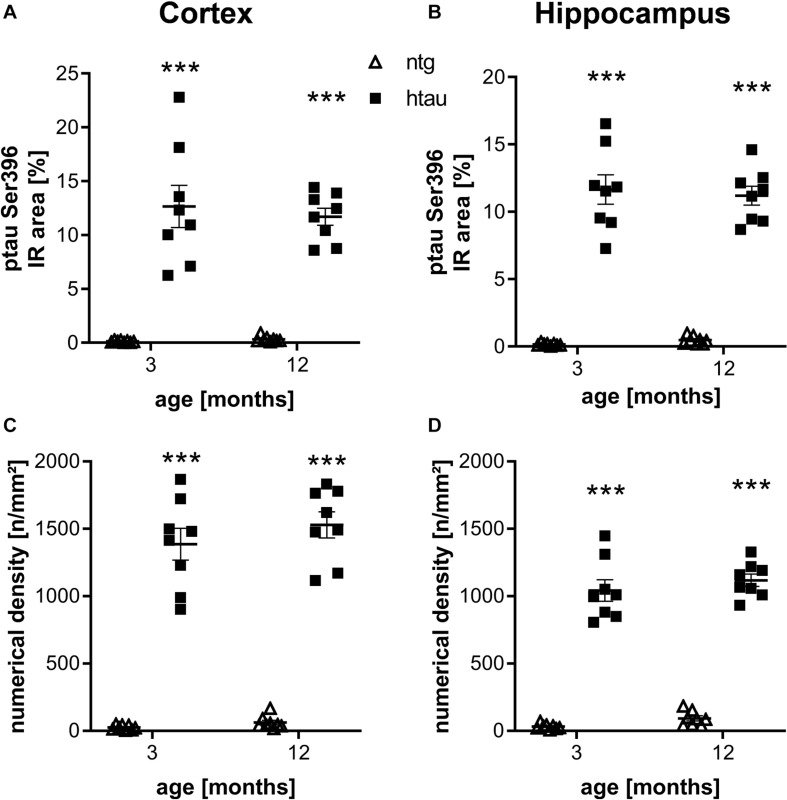
Quantification of ptau Ser396 levels in the cortex and hippocampus of 3 and 12 month old htau mice compared to ntg littermates by PHF13 antibody. (A,B): Immunoreactive area in percent in the cortex (A) and hippocampus (B). (C,D): Object density in n/mm2 in the cortex (C) and hippocampus (D). n = 8 per group, 5 slides per animal. Mean + SEM; Two-way ANOVA with Bonferroni’s post hoc test; ***p < 0.001.